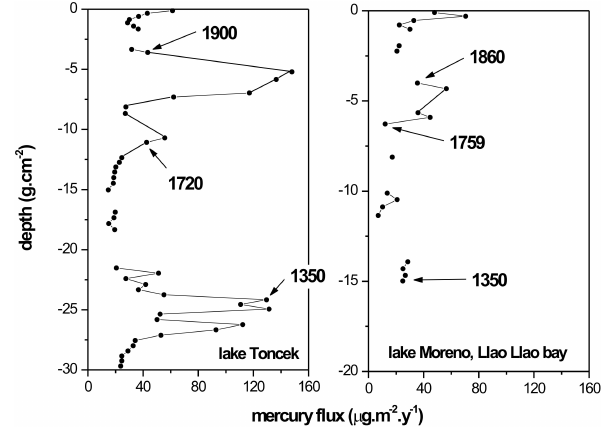
Fig. 5. Mercury fluxes to sediments. Lake Tonˇcek and Lake Moreno Oeste (Llao Llao bay) sedimentary